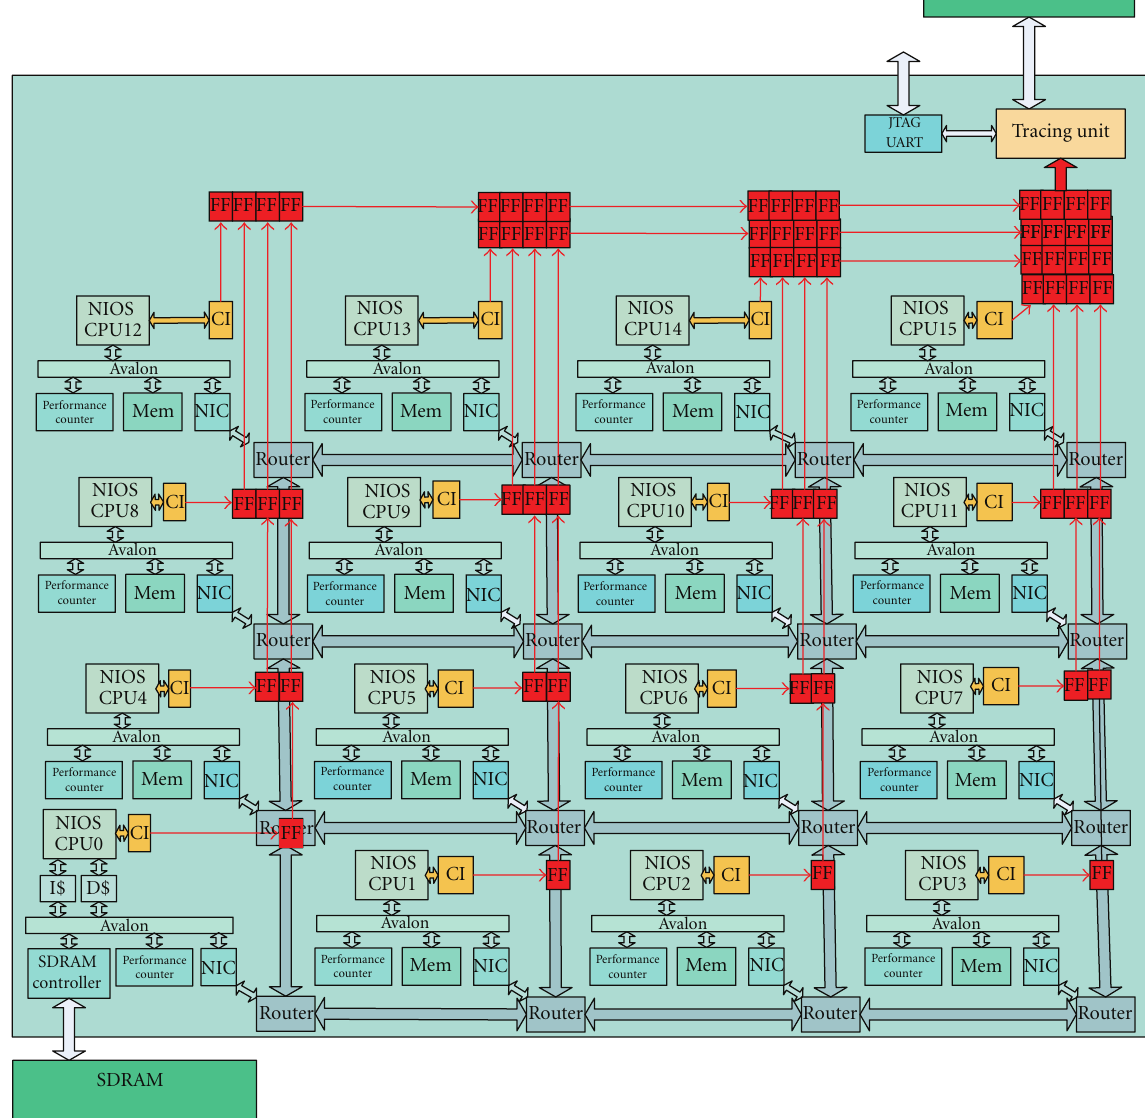
Figure 15: Complex trace logging